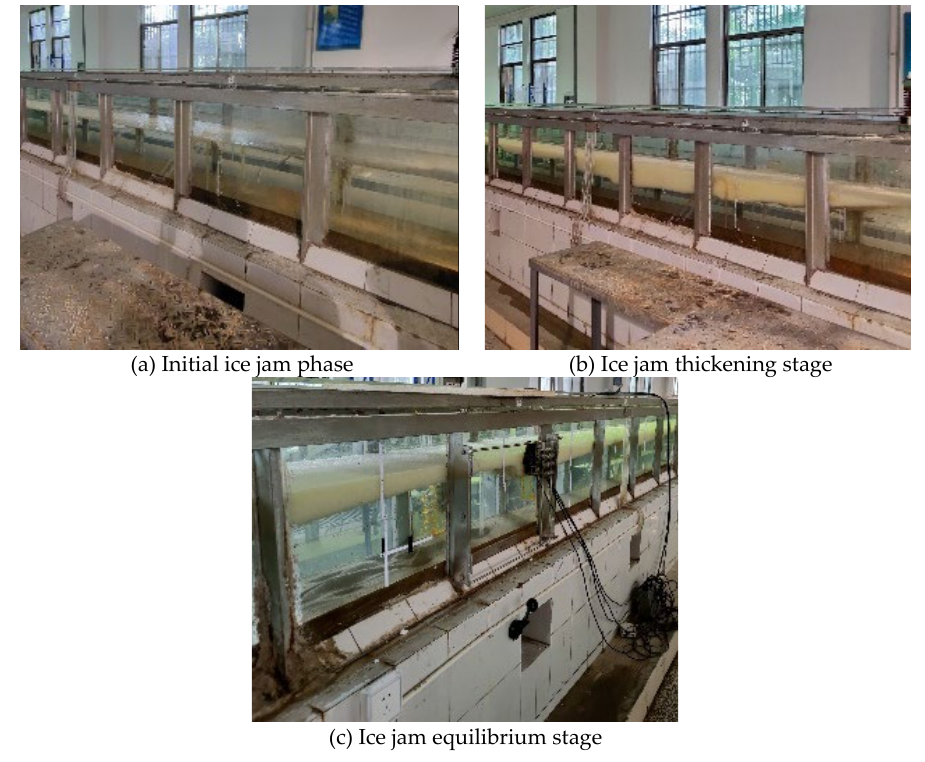
Figure 3. Development of an ice jam at different stages.